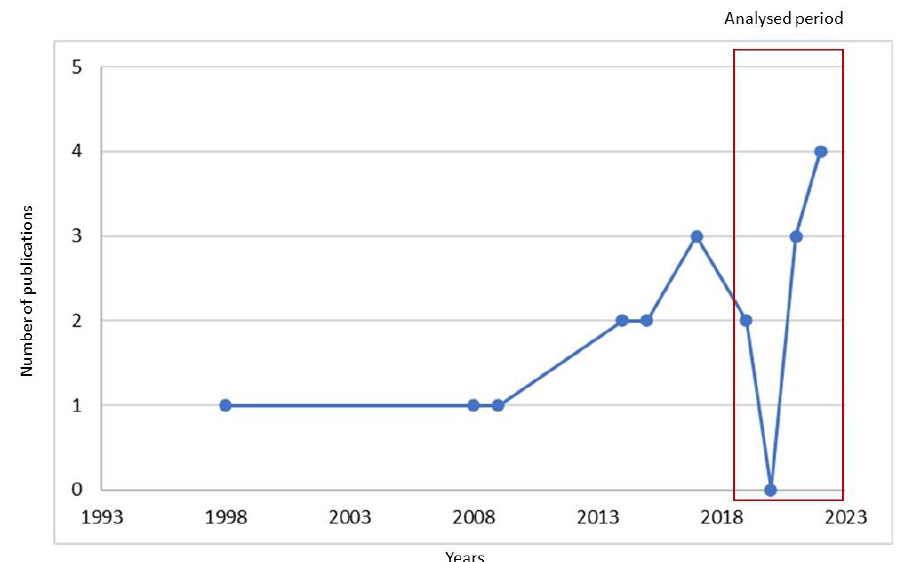
Figure 11. Chronological view of the studies on wind energy and architectural heritage: 19 scientific documents have been realized from 1998 to 2023, 7 of them in the years 2020–2023 (Source: Author’s elaboration using Scopus data).